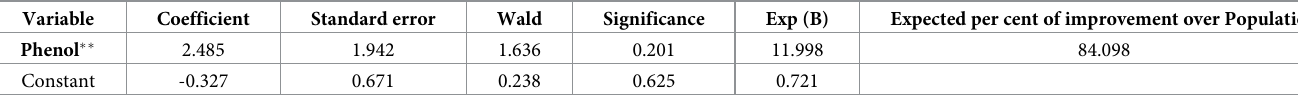
Table 5. Logistic estimate of biochemical constituent influencing tea mosquito bug